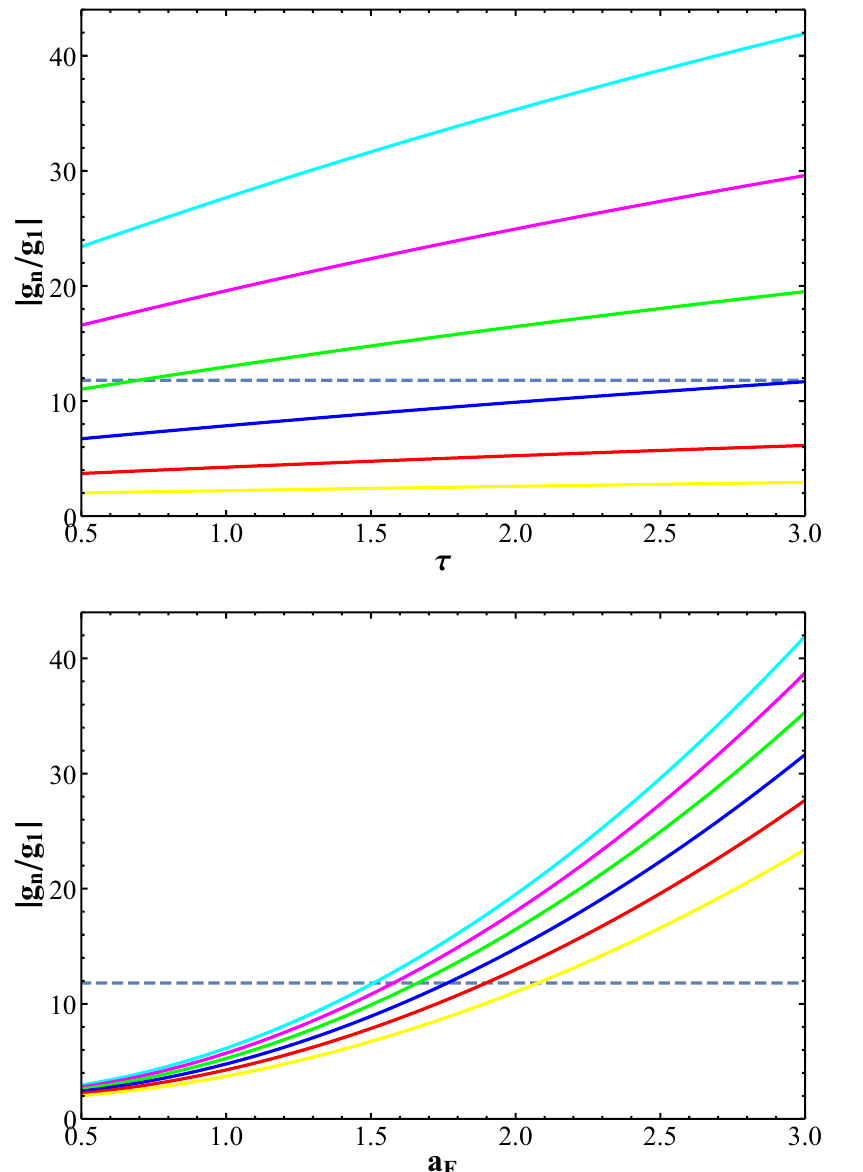
Figure 5 . (Top) The limit of the ratio | g n /g D | as n → ∞ , as a function of τ for a F = 3 (cyan), DM 5/2 (magenta), 2 (green), 3/2 (blue), 1 (red), and 1/2 (yellow), respectively. The dashed line denotes the largest possible ratio such that the couplings of the DM particle to the gauge boson KK modes remain perturbative for all KK modes in the theory, assuming g D = 0 . 3 (Bottom) As in the previous panel, but now as a function of a F assuming τ = 3 (cyan), 5/2 (magenta), 2 (green), 3/2 (blue), 1 (red), and 1/2 (yellow),